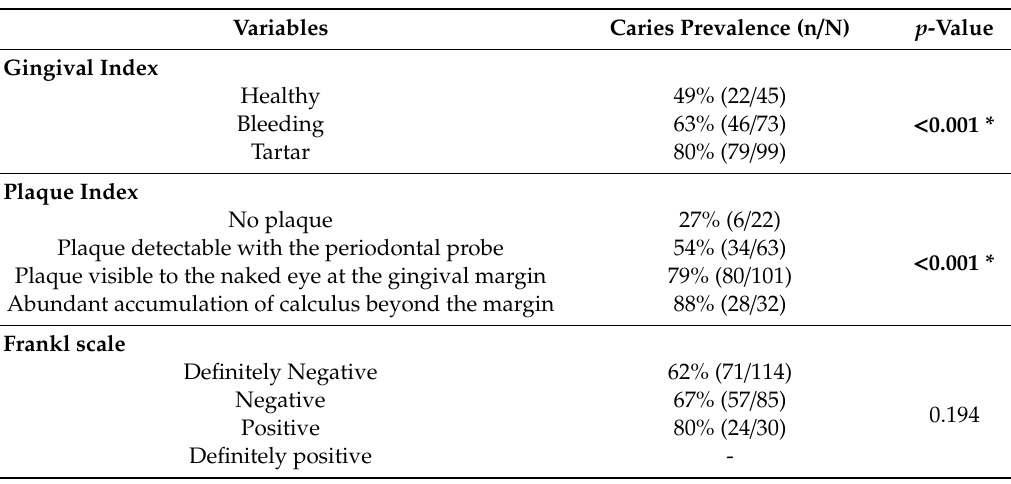
Table 3. Caries prevalence in relation to Gingival Index, Plaque Index, and ASD severity (measured as the Frankl scale rating). N = total number of participants in each category; n = number of participants with positive DMFT / dmft in each category. p -values < 0.05, corresponding to statistically significant di ff erences, are marked with an asterisk and the corresponding variable is highlighted in bold.